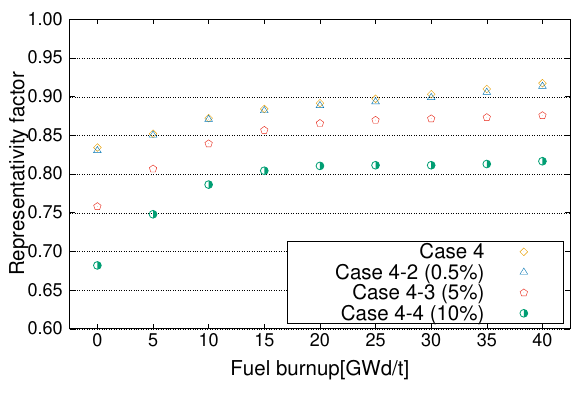
Figure 11. Sensitivity of target and fictitious parameter (Pu-241 capture,Case4-2)